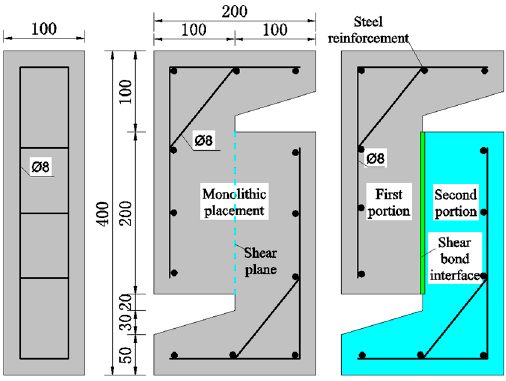
Figure 1. Direct shear test specimen. Table 1. Mix proportion of the ultra-high performance concrete (UHPC; mass).